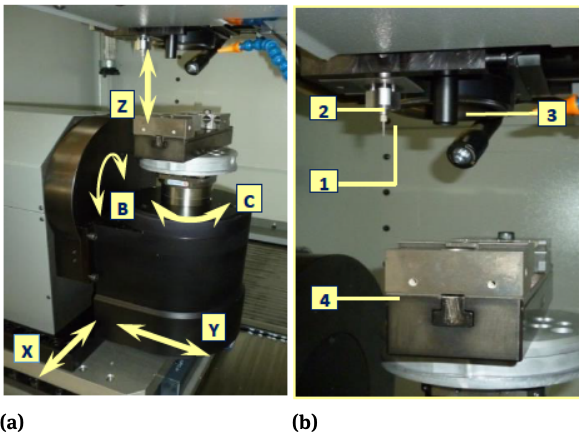
Figure 3: Laser machine workspace; a – laser machine tool kine- matic structure (X, Y, Z – translation motions, B, C – rotation mo- tions), b – main parts of workspace (1 – beam guidance with the highly dynamic scanner acts as an optical axis system, 2 – Z-level measuring probe, 3 – positioning and measuring CCD camera, 4 – workpiece).